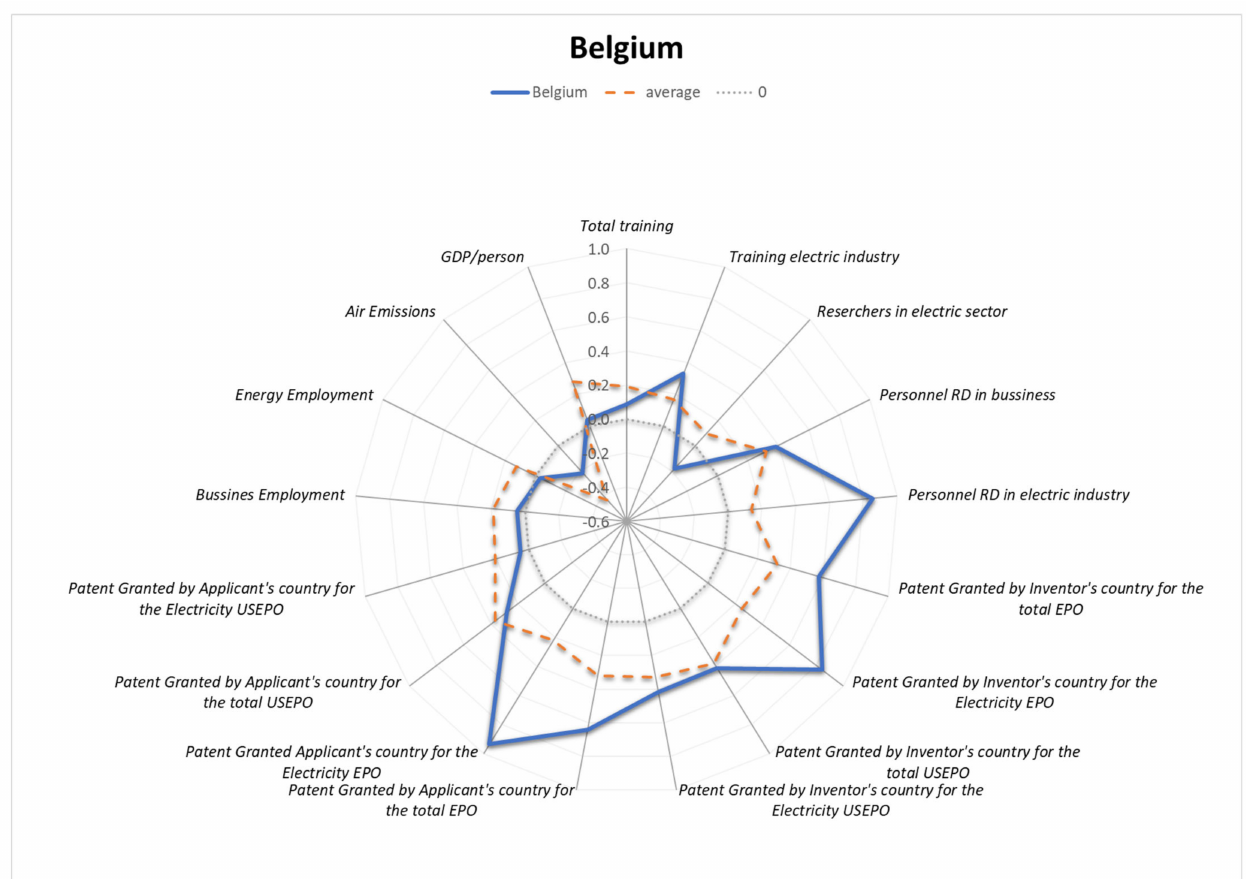
Figure 12. Synergy and trade-off occurrence—BE. Source: Authors’